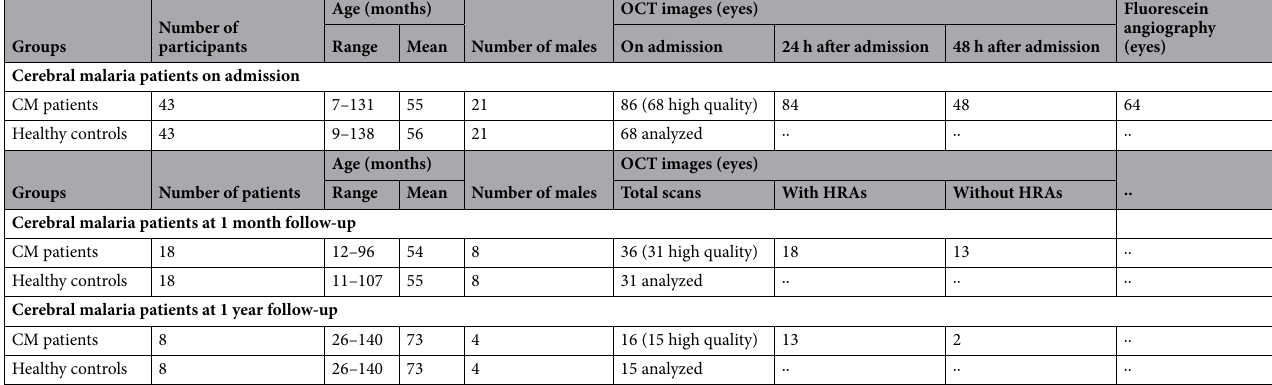
Table 1. Demographic data of patients with cerebral malaria (CM) and controls on admission and follow-up visits.